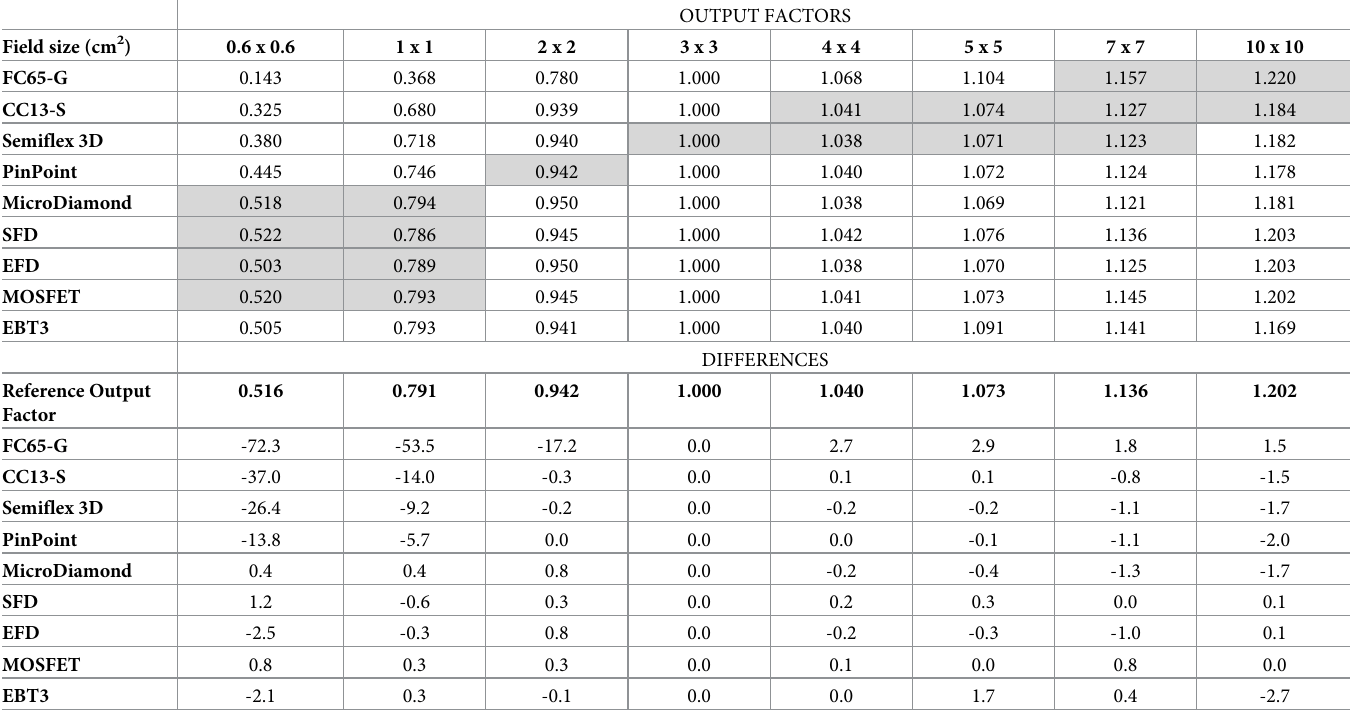
Table 2. Output factors for different detectors depending on the field size for 6 MV beams.